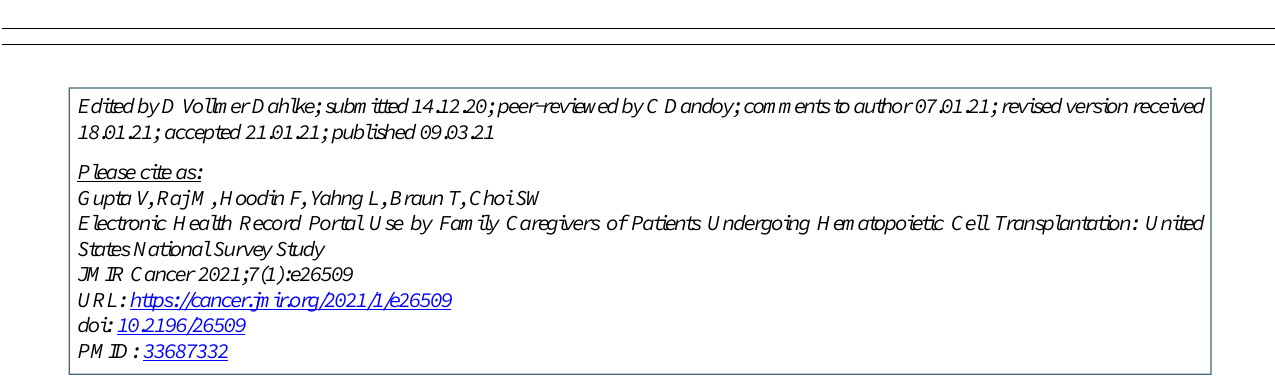
AUC: area under the curve BMT InfoNet: Blood and Marrow Transplant Information Network nBMTLINK: National Bone Marrow Transplant